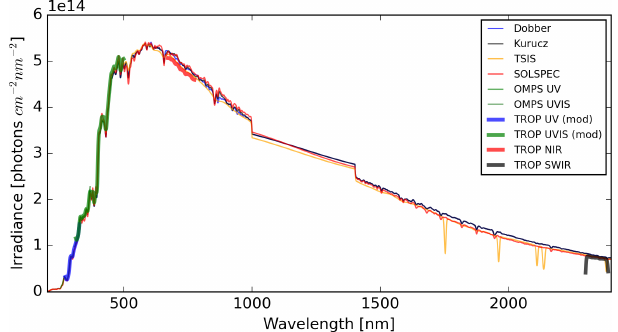
Figure 19. The solar spectrum according to reference spectra (thin lines) such as Dobber (red), Kurucz (black), TSIS (orange), SOL- SPEC (red), and OMPS (green) and the four TROPOMI spectrom- eters via diffuser QVD1 (thick lines) in orbit 2818. The TROPOMI UV and UVIS spectra are modified as described in the text. All spectra were convoluted with a Gaussian kernel with a 3.0nm stan- dard deviation on the Dobber